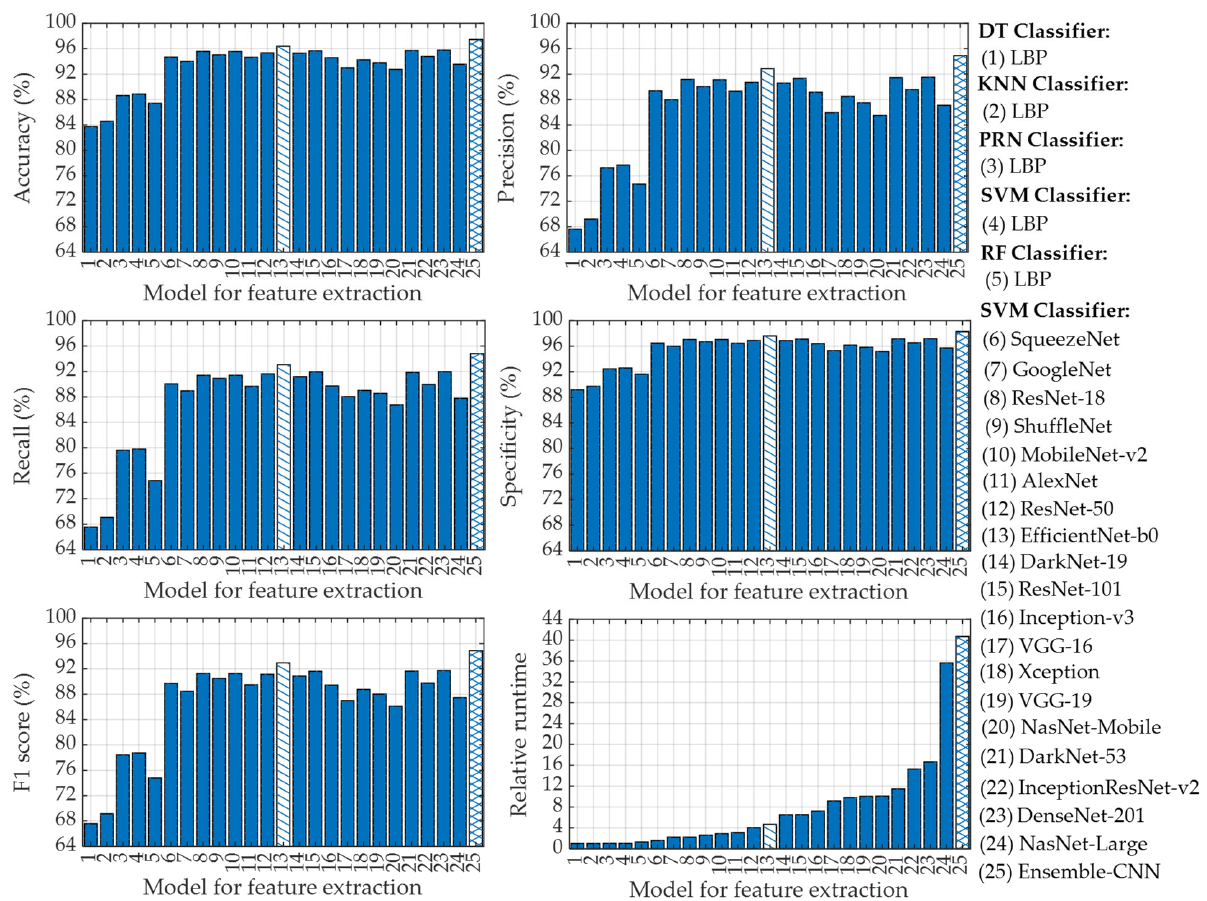
Figure 14. Classification performances for using LBP ‐ based DT, LBP ‐ based KNN, LBP ‐ based PRN, LBP ‐ based SVM, LBP ‐ based RF, CNN ‐ based SVM, and ensemble ‐ CNN ‐ based SVM classifiers. LBP-based SVM, LBP-based RF, CNN-based SVM, and ensemble-CNN-based SVM